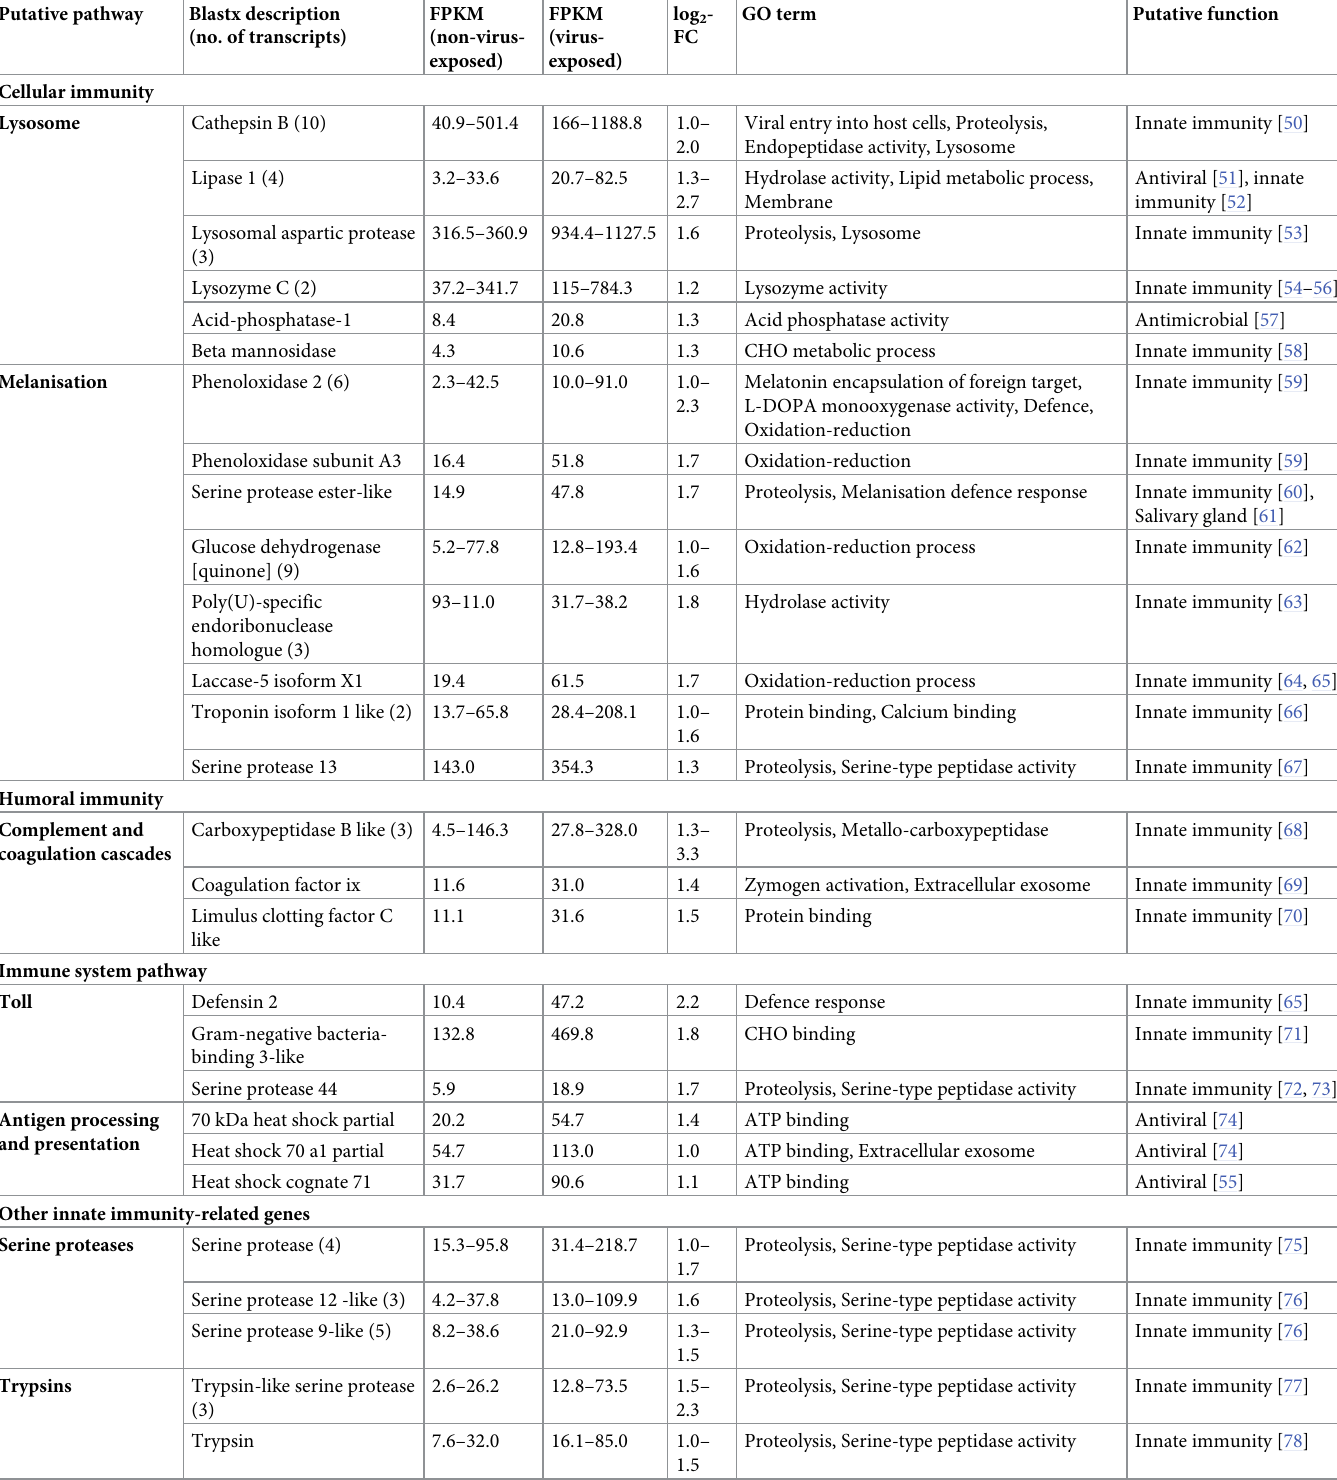
Table 2. List of significantly up-regulated DE (q < 0.01, log 2 -FC > 1.0, FPKM > 10) transcripts categorized based on Blastx descriptions and GO terms that are pre- dicted to be associated with innate immunity, salivary glands and fitness and fecundity in CaCV-exposed and non-exposed Thrips palmi transcriptome. Putative